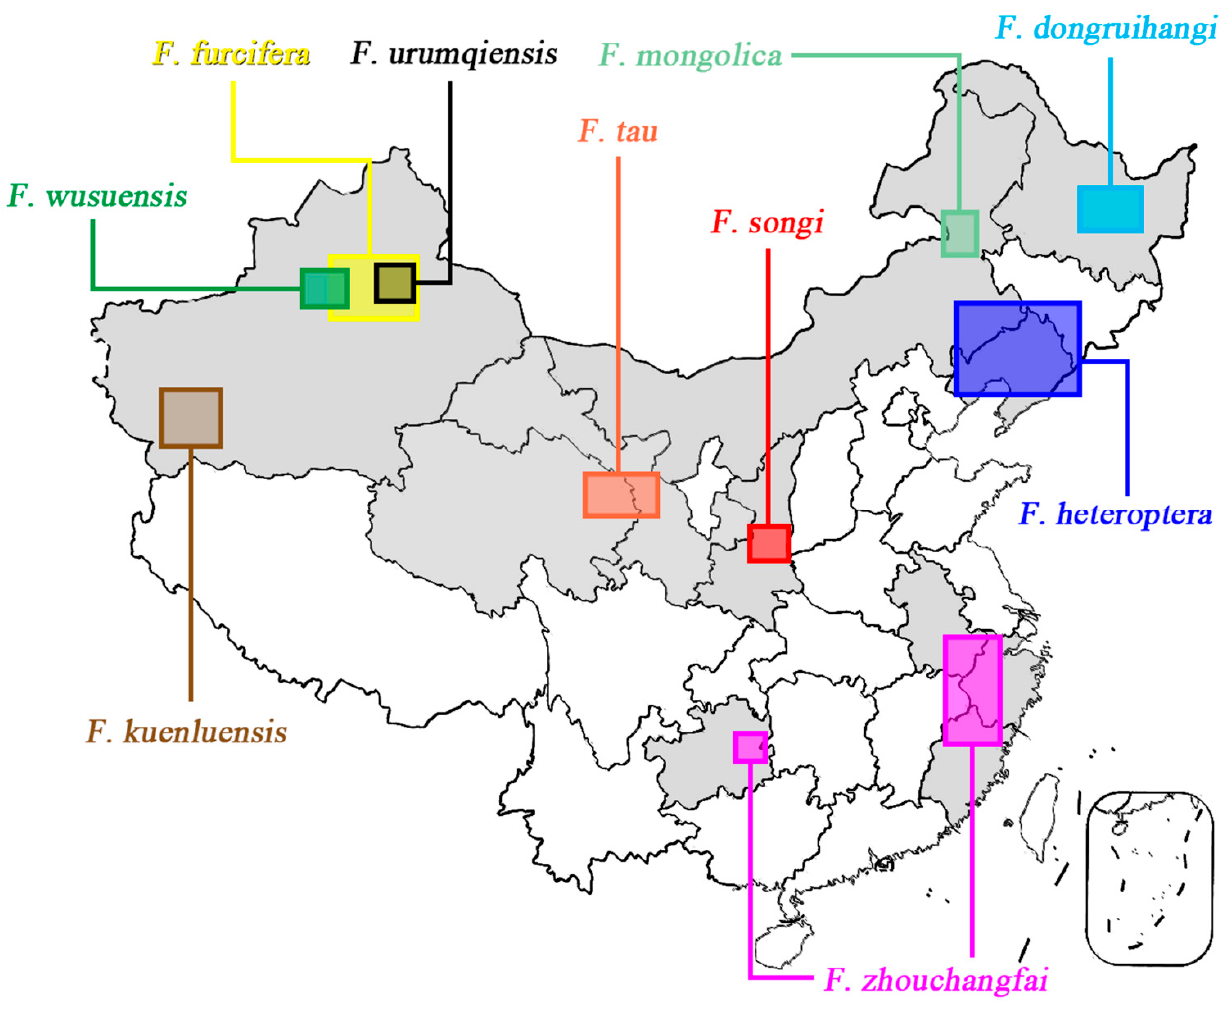
Figure 17. Distribution of Filchneria in China.